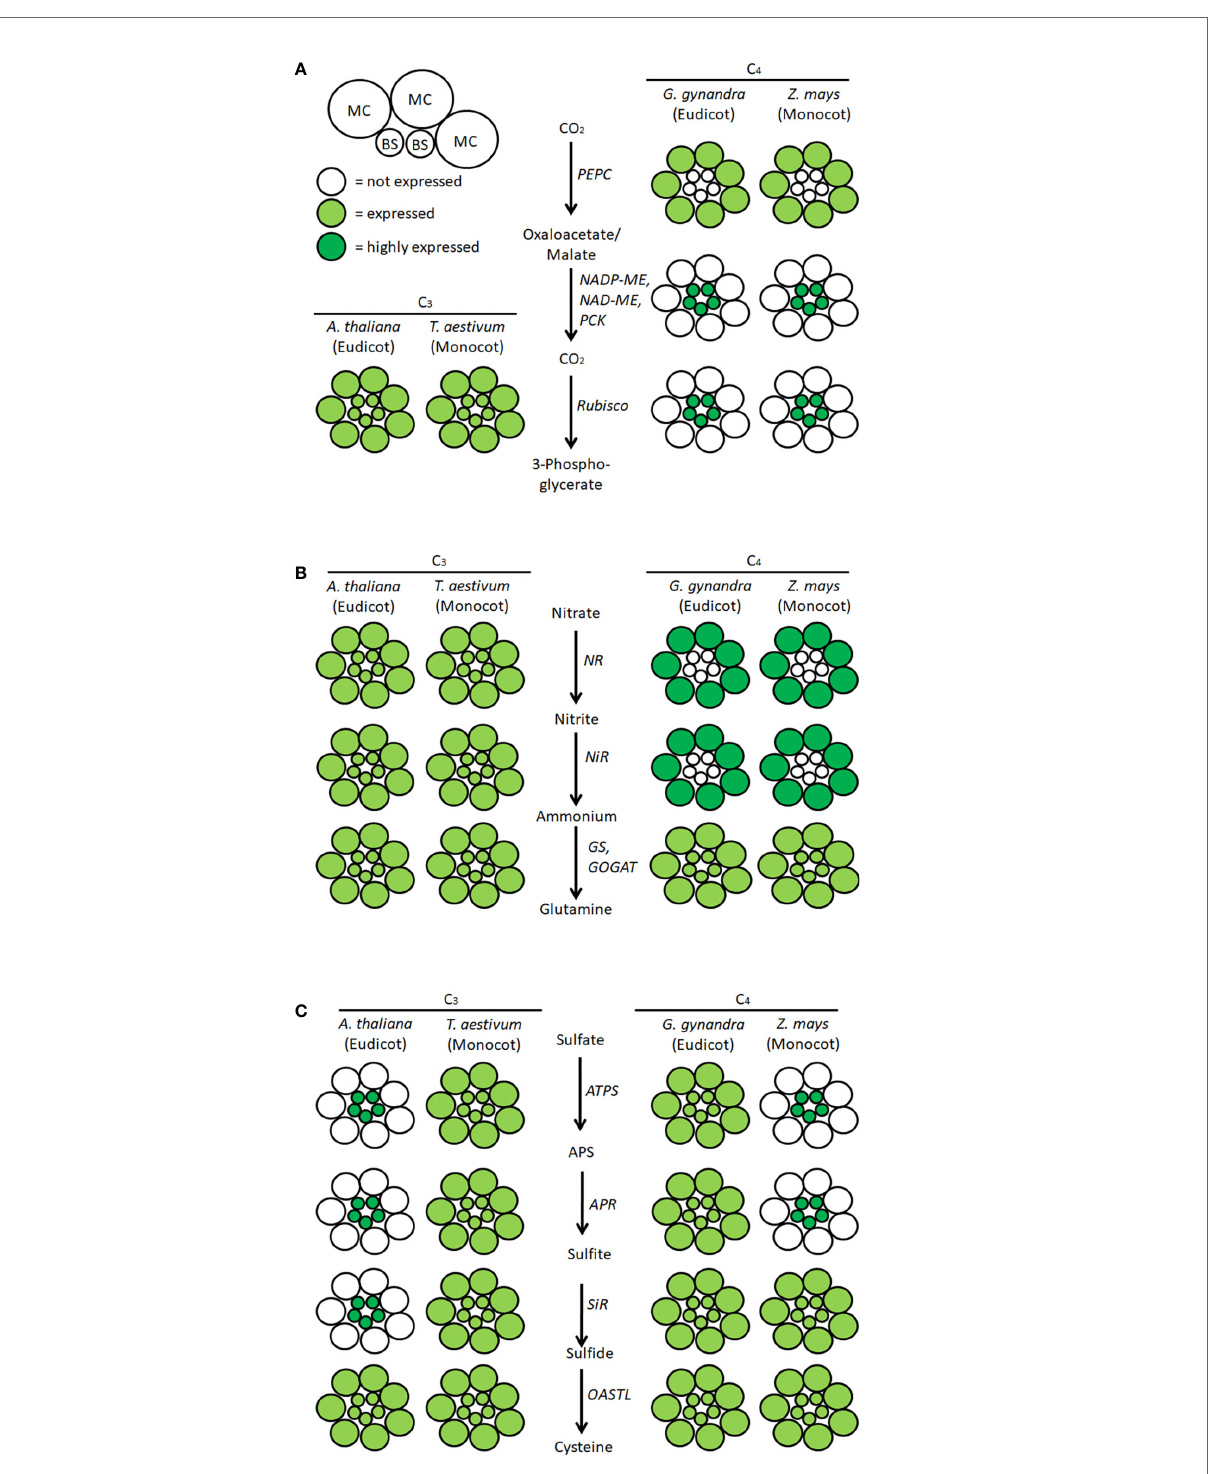
FIGURE 1 | Scheme of localization of the pathways of carbon, nitrate, and sulfate assimilation in exemplary C 3 and C 4 plants. Schematic localization of key enzymes of (A) CO 2 , (B) nitrate, and (C) sulfate assimilation in mesophyll cells (MC) and bundle sheath cells (BS) of representative species for C 3 and C 4 monocots and dicots was compiled from the literature described in the manuscript. MC, mesophyll cells; BS, bundle sheath cells; PEPC, phosphoenolpyruvate carboxylase; ME, malic enzyme; PCK, phosphoenolpyruvate carboxykinase; NR, nitrate reductase; NiR, nitrite reductase, GS, glutamine synthetase; GOGAT, glutamate synthase; ATPS, ATP sulfurylase; APS, adenosine 5´-phosphosulfate; APR, APS reductase; SiR, sul fi te reductase; OASTL, O-acetylserine